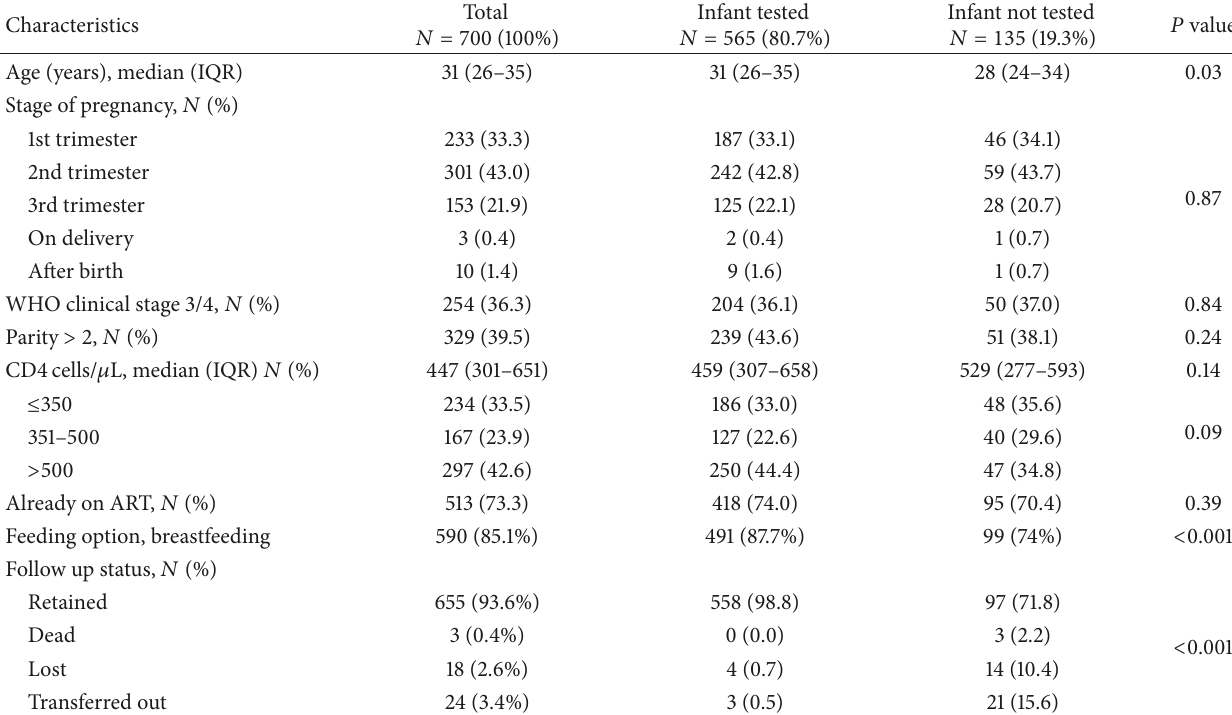
Table 1: Baseline and follow-up characteristics of the 700 women enrolled in the HIV-antenatal integrated clinic and retained into care up to the end of the